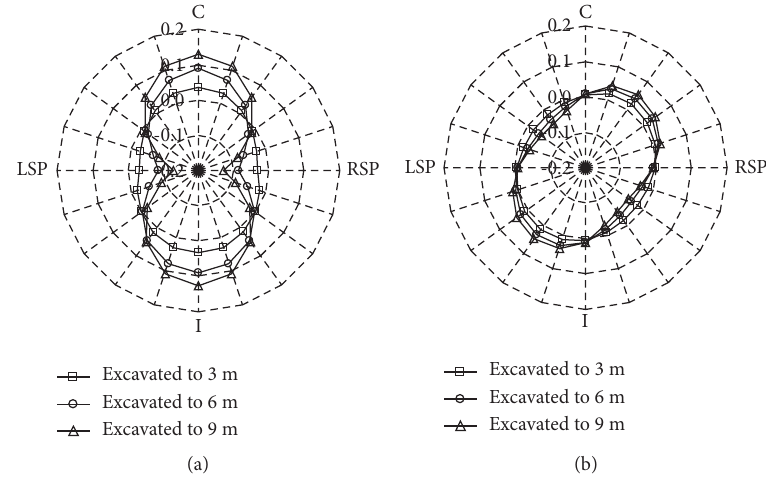
Figure 3: Tunnel radius change ( Δ R/R: %) in tunnel transverse for case C and case S. (a) Case C and (b) case